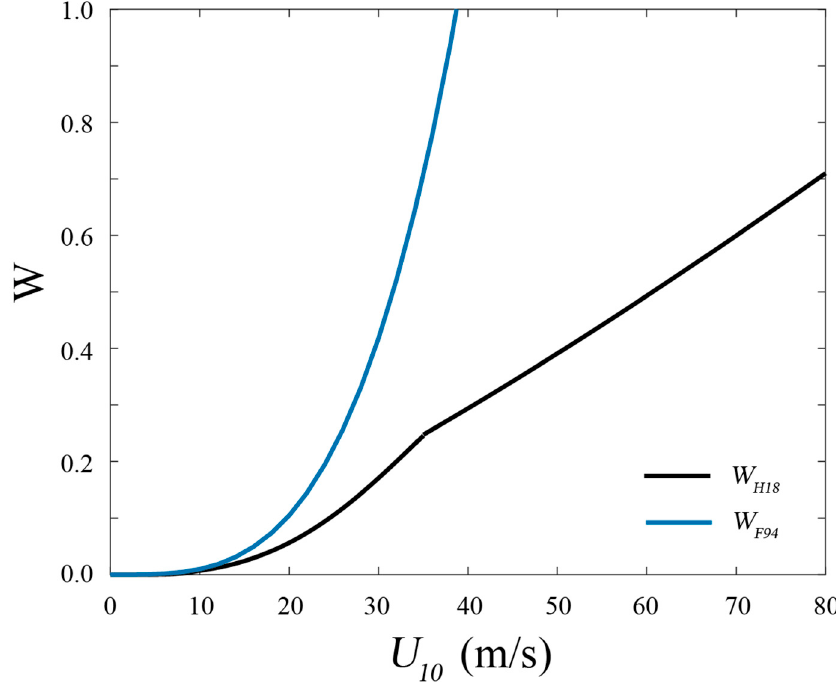
Figure 3. The comparison of W H 18 and W F 94 with 10 m wind speed U 10 . The black line represents W H 18 , and the blue line represents W F 94